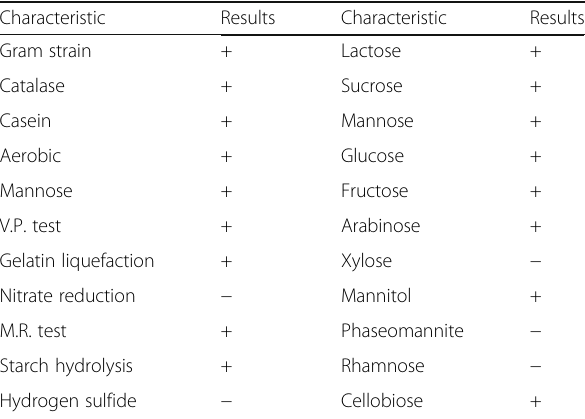
Table 2 Biological and biochemical analysis of antagonistic bacteria